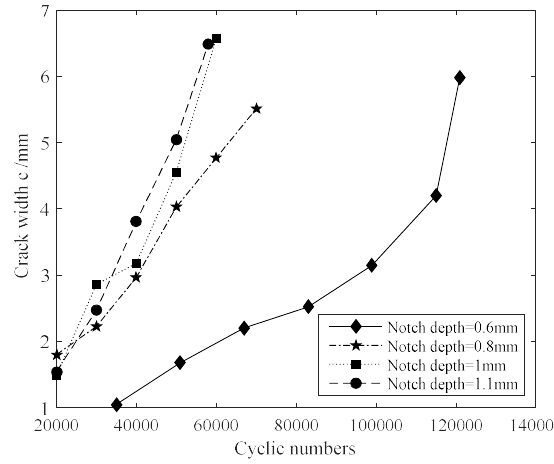
Figure 19. Variation of crack width with cyclic numbers.